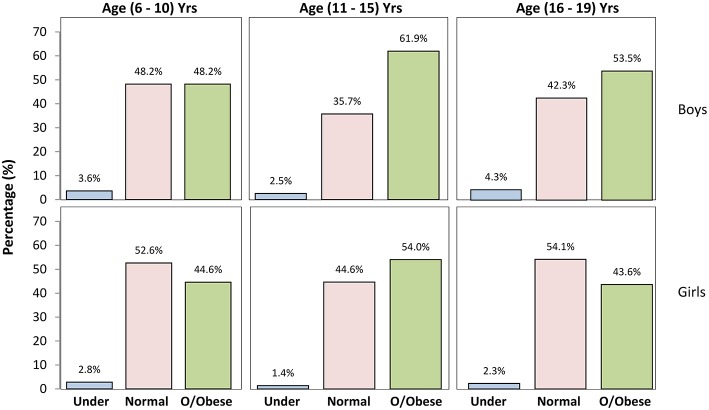
The prevalence of underweight, normal weight and combined overweight and obese (o/obese) by age group and gender among Kuwaiti students.